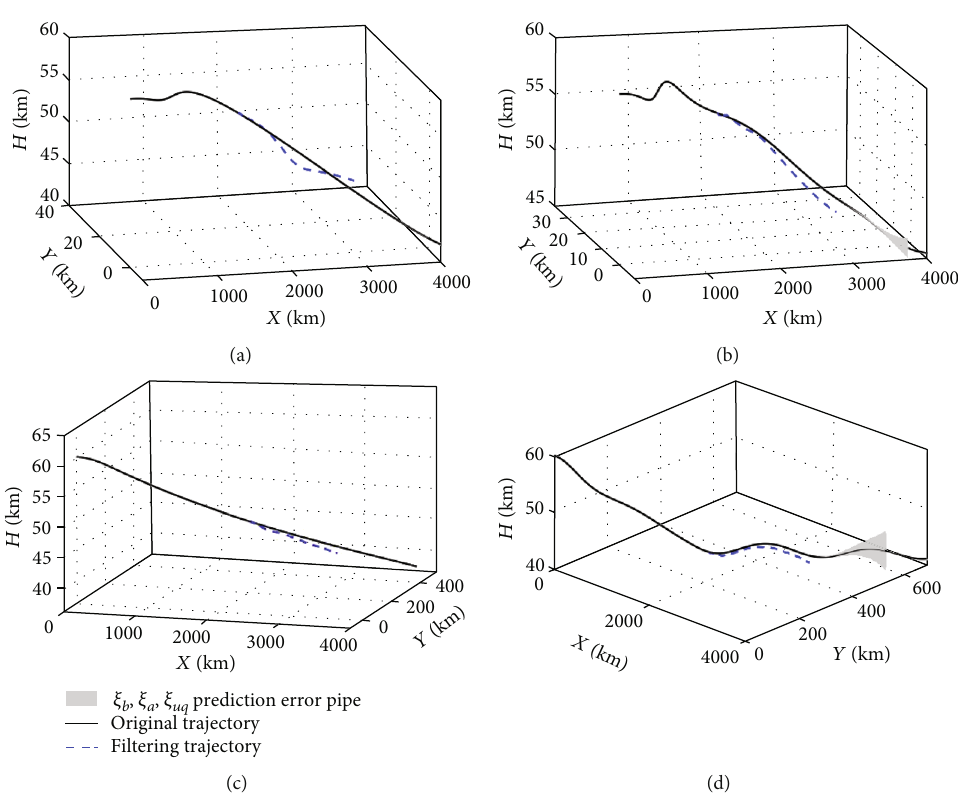
Figure 11: Prediction error pipe. (a) is the prediction error pipe in weaving equilibrium glide. (b) is the prediction error pipe in weaving skip glide. (c) is the prediction error pipe in turning equilibrium glide. (d) is the prediction error pipe in turning skip